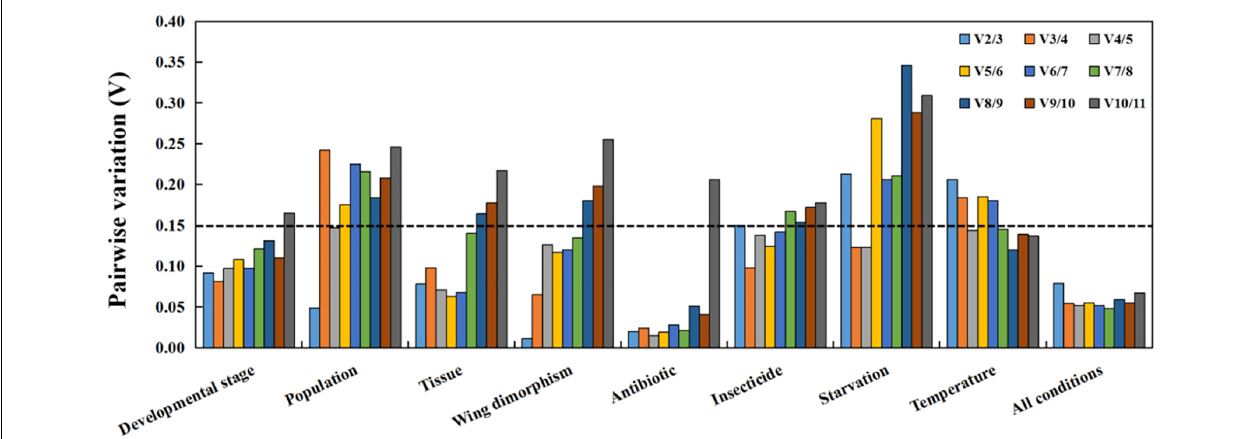
FIGURE 3 | Optimal number of reference genes for accurate normalization as determined by geNorm. The Vn/n+1 value indicates the pairwise variation ( Y -axis) between two sequential normalization factors and was used to determine the optimal number of reference genes for an accurate data normalization. A -value < 0.15 indicates that an additional reference gene will not significantly improve the normalization.